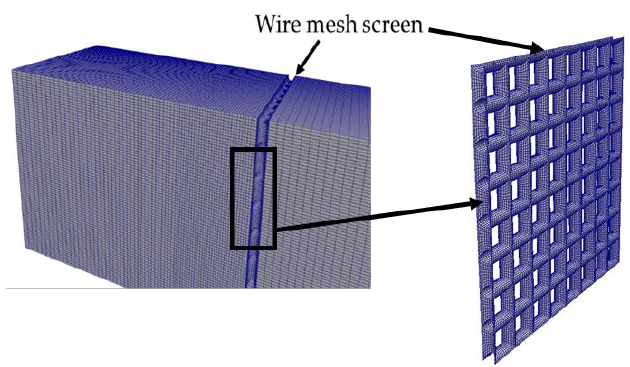
Figure 4. Structured multi-block grid for an idealized wire mesh